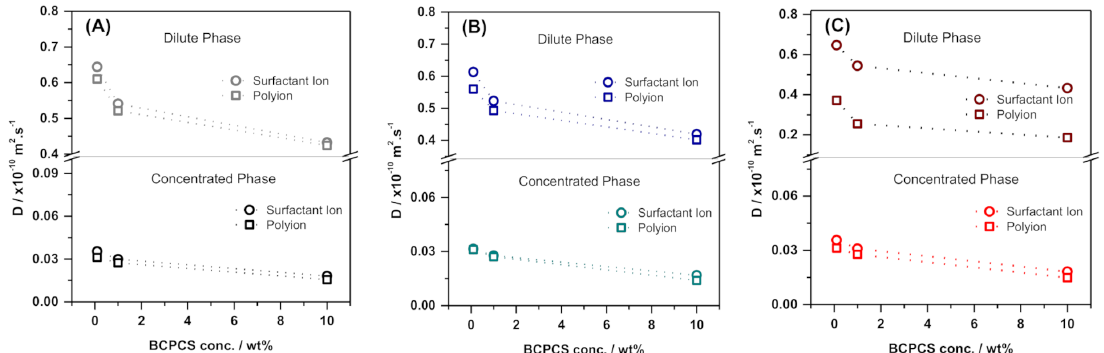
Figure 5. Self-diffusion coefficients (D) for surfactant ions and polyions in the concentrated and dilute phases obtained for centrifuged samples at different (overall) initial concentrations for ( A ) C 12 S, ( B ) C 16 S, and ( C ) C 12 L. The lines are guides for the eye. The terms C 12 and C 16 refer to the surfactant alkyl chain length, whereas S and L refer to the length of the PAAm block in the BCP (short and long,